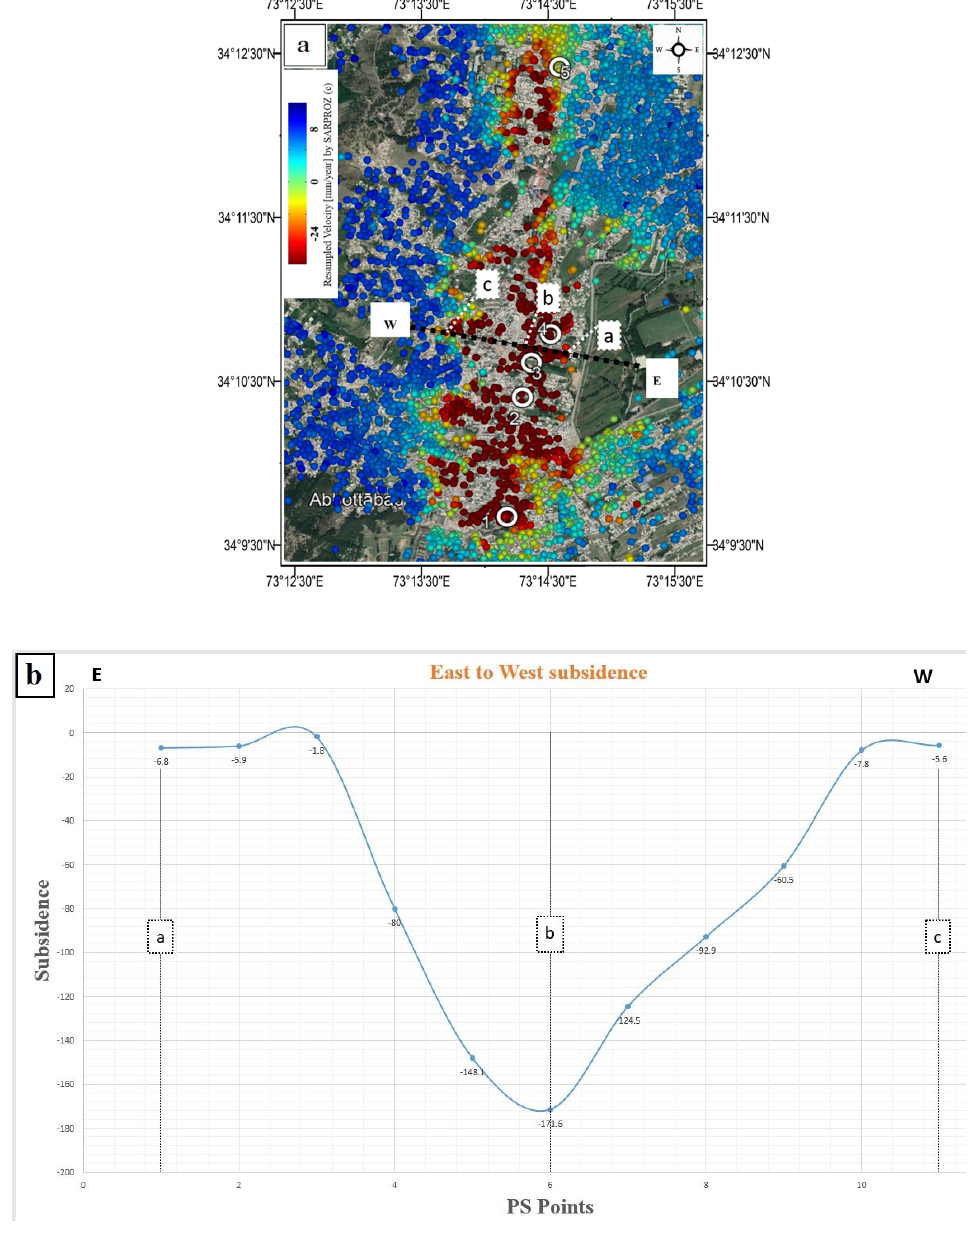
Figure 11. ( a ) Subsidence profile from east to west; ( b ) east–west subsidence trend graph (2017–2019). In Figure 11a, the black line illustrates the east–west subsidence profile, where a, b, and c represent subsidence at some specific points. Figure 11b represents a subsidence fluctuation graph of the east–west subsidence profile (x-axis mark PS points, y-axis sub- sidence). In Figure 11b, the (a), (b), and (c) highlight subsidence at the corresponding spe- cific points, as shown in Figure 11a. The north–south subsidence trend was also analyzed in the final subsidence map. This subsidence profile suggests that the subsidence was lower ( − 28 mm, − 32.8 mm, etc.) in the northern part of the city and experienced a small increase ( − 116.8 mm) towards the center, and again decreased ( − 80.4 mm) as given in graph at point c (Figure 12b). The